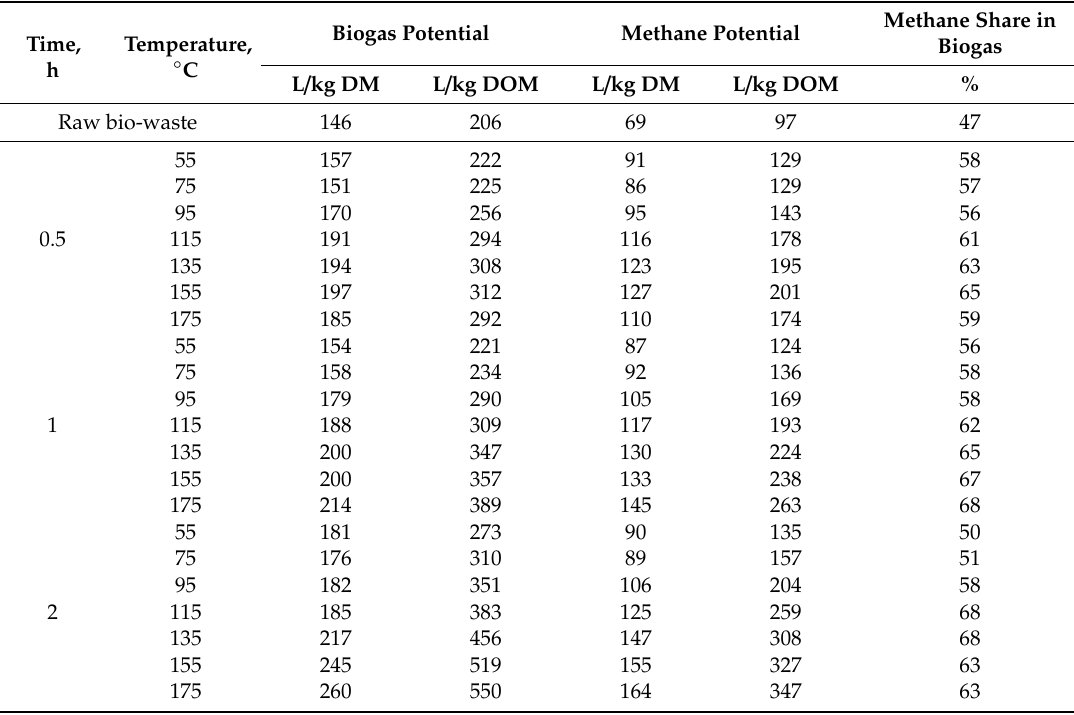
Table 4. Biogas and methane potential in raw and thermally disintegrated